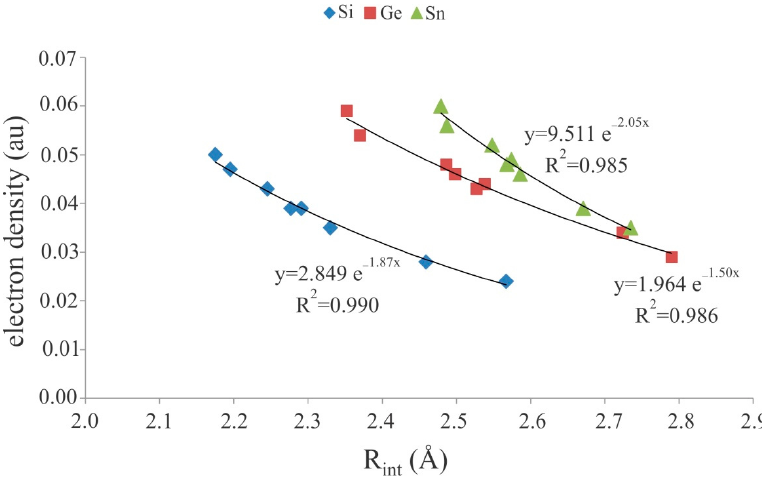
Figure 5. Exponential relationship between the M ··· N binding distances and electron density at the corresponding BCPs of the cationic tetrel-bonded complexes. Table 4. Electron density ( ρ BCP , au), its Laplacian ( ∇ 2 ρ BCP , au) and total electron energy density (H BCP , au) at the M ··· Z BCPs, and NBO stabilization energies due to the LP(N) → BD* M-C orbital interaction (E (2) , kcal/mol), net charge-transfer (q CT , e) and Wiberg bond index (WBI) values of the cationic tetrel-bonded